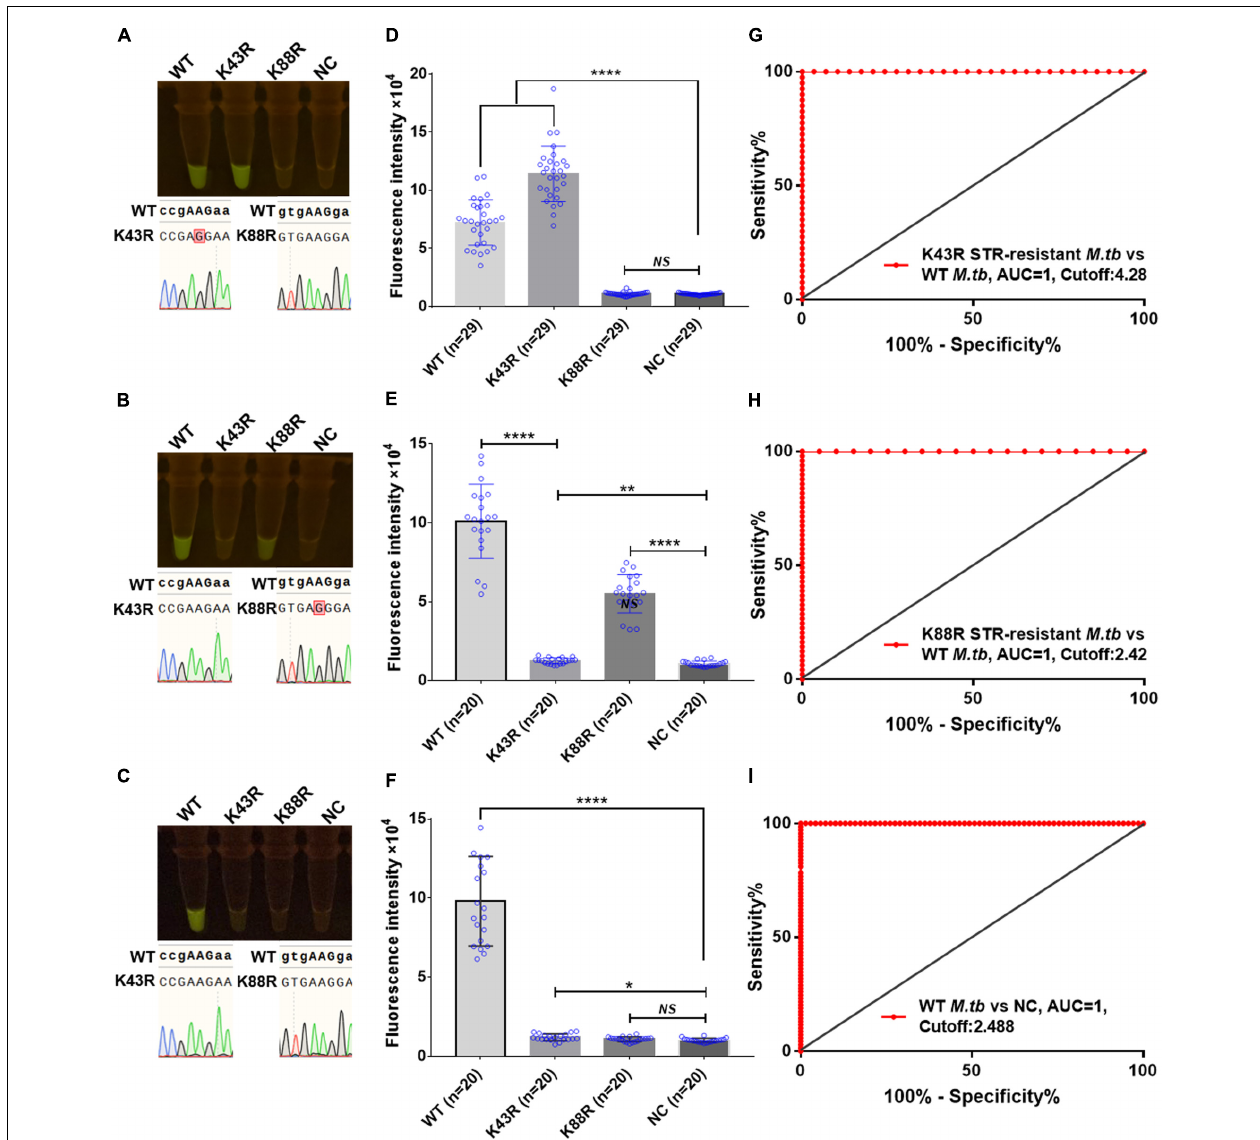
FIGURE 6 | Cas12a RR detects the clinical culture strains of streptomycin (STR)-resistant M. tuberculosis . The fluorescent images (A–C) and fluorescence intensity (D–F) at 15 min of reaction are shown. Diagnostic performance of Cas12a RR fluorescence system (G–I) . (G) Receiver operating characteristic (ROC) curve of the fluorescence value of K43R STR-resistant M.tb vs . WT M.tb control group. (H) ROC curve of the fluorescence value of K88R STR-resistant M.tb vs . WT M.tb control group. (I) ROC curve of the fluorescence value of WT M.tb vs . NC control group. Cutoff values were determined using Youden’s index, i . e ., the maximum of (sensitivity + specificity – 1). The content of the whole-genome template of the clinical sample used in the above-mentioned detection reaction is 1 ng. Data are presented as the mean ± SEM from at least three independent experiments. * p < 0.05, ** p < 0.01, *** p < 0.001, and **** p <